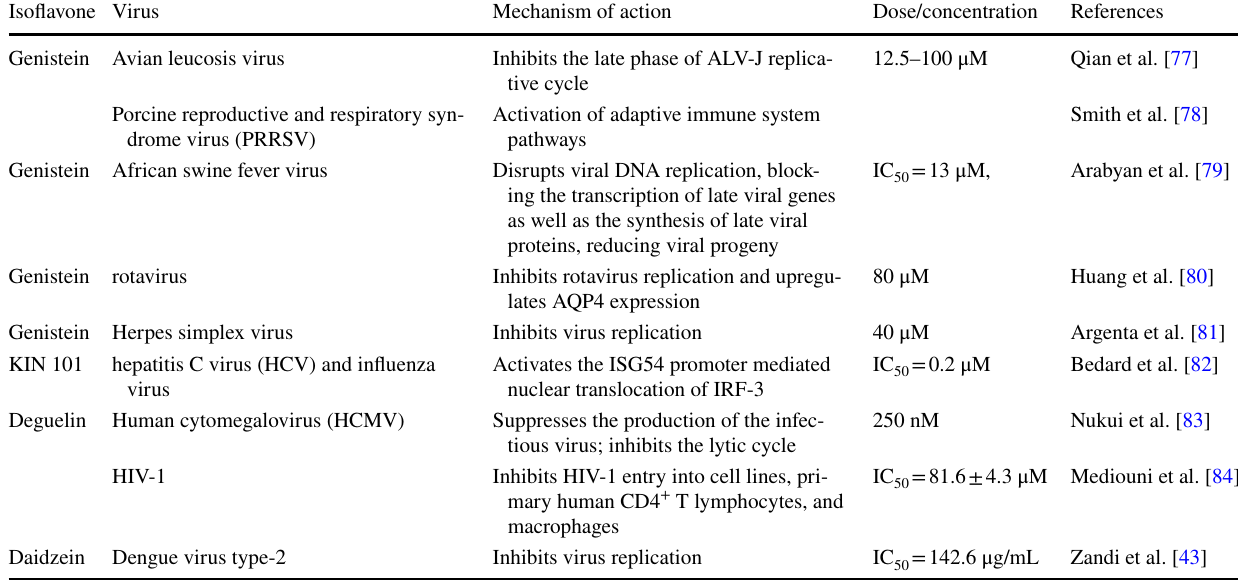
Table 7 Anti-virus activity of isoflavones Isoflavone